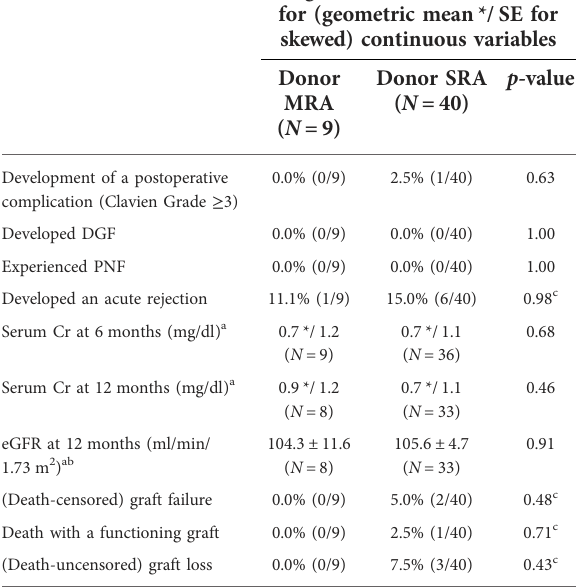
TABLE 4 Associations of clinical outcomes with donor multiple renal artery status. Outcome variable Percentage with characteristic for categorical variables; mean ± SE for (geometric mean */ SE